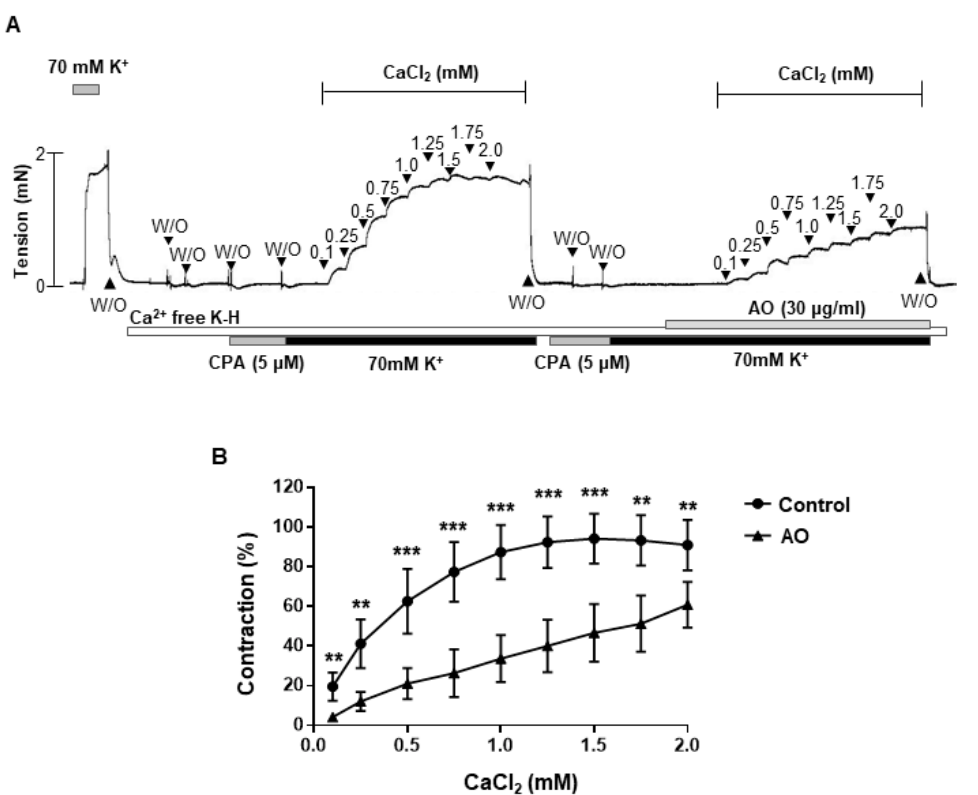
Figure 4. Decrease in Ca 2+ -induced contraction in A. officinarum extract-treated mesenteric arteries. ( A ), Representative trace showing the effect of A. officinarum in the mesenteric arteries, treated with cumulative addition of CaCl 2 (0.1–2 mM). ( B ), statistical analysis of contraction induced by CaCl 2 in the mesenteric arteries, with or without A. officinarum . Mean ± SD (n = 7). ** p < 0.01, *** p < 0.001 (CPA: cyclopiazonic acid; W/O: wash out; AO: Alpinia officinarum extract). 2.5. A. officinarum Extract Inhibited Phosphorylation of 20 kDa Myosin Light Chain (MLC 20 ) in Vascular Smooth Muscle Cells